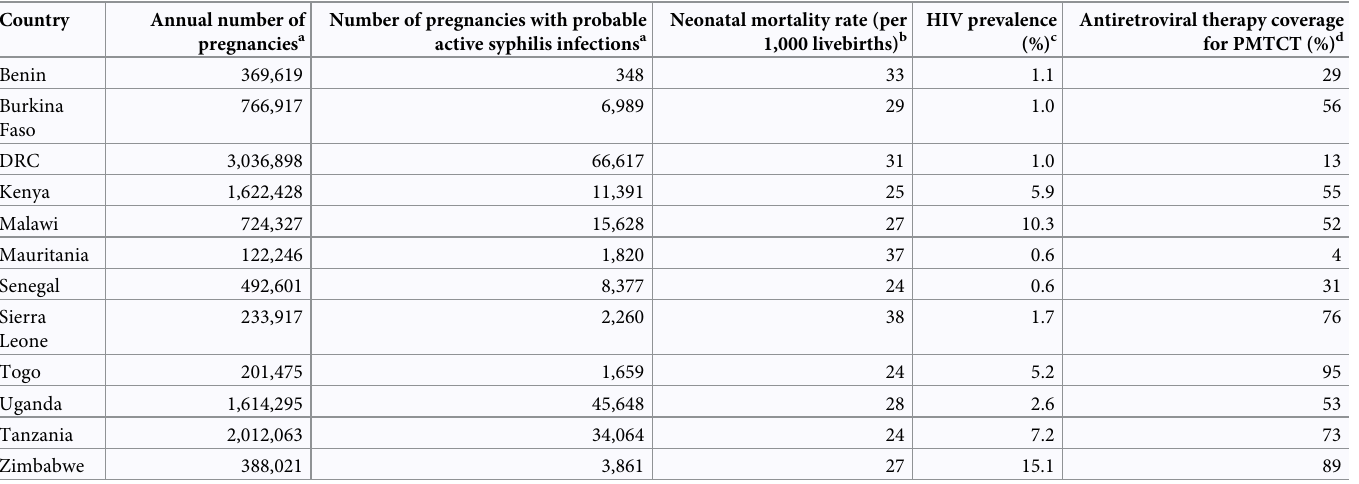
Table 1. Characteristics of 12 countries included in the study